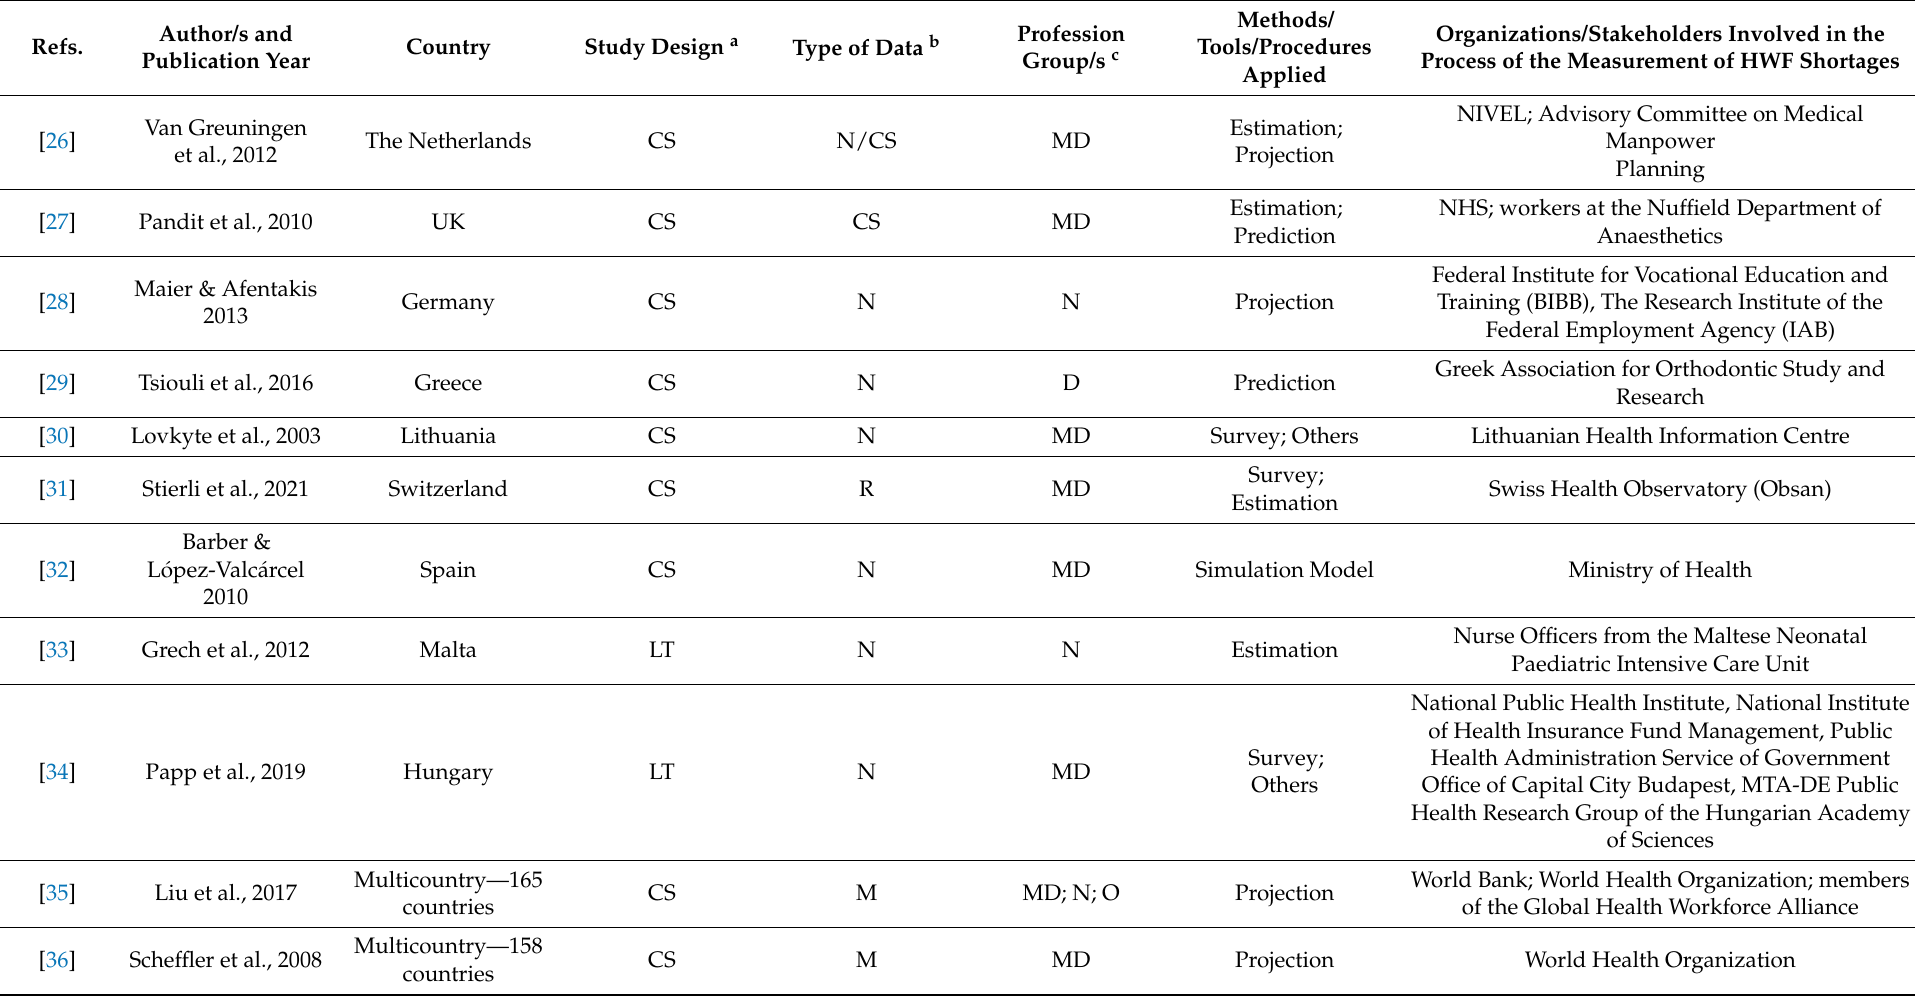
Table 1. Empirical studies